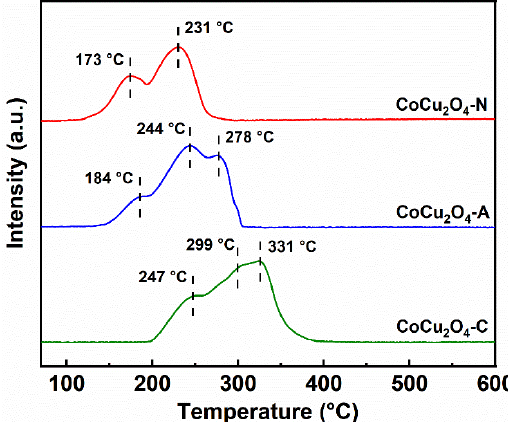
Figure 5. H 2 -TPR profiles of the CuCo 2 O 4 - x ( x = N, A and C) catalysts. Figure 6a shows the O 2 -TPD profiles of the CuCo 2 O 4 - x ( x = N, A and C) catalysts. The oxygen desorption peaks below 500 °C belong to adsorbed oxygen species (e.g., O 2 , O - 2 and O - , labeled as α -O 2 ) [32], while the oxygen desorption peaks between 600 °C and 850 °C belong to the lattice oxygen species (O 2− , labeled as β -O 2 ) [33]. Figure 6b shows the enlarged O 2 -TPD profiles in the temperature range of 50 °C to 550 °C. The oxygen desorp- tion peaks within 50 – 300 °C and 300 – 500 °C correspond to the physically adsorbed oxygen (α 1 -O 2 ) and chemically adsorbed oxygen (α 2 -O 2 ) species, respectively [34,35]. Generally, the adsorption of oxygen followed the procedure of O 2 → O − 2 → O - → O 2− [27]. The CuCo 2 O 4 -N catalyst shows an extra oxygen desorption peak in the temperature range of 200 °C to 250 °C compared to the CuCo 2 O 4 -A and CuCo 2 O 4 -C. The extra oxygen desorption peak could be attributed to physically adsorbed oxygen (α 1 -O 2 ), indicating that the catalysts had better oxygen mobility [36]. Similarly, Li et al. also reported that the CuCo 2 O 4 and NiCo 2 O 4 catalysts showed an extra oxygen desorption peak in the temperature range of 200 °C to 250 °C compared to the ZnCo 2 O 4 . The catalytic performance of CuCo 2 O 4 and NiCo 2 O 4 catalysts were found to be far superior to that of ZnCo 2 O 4 in toluene combustion [7]. The desorption amount of α 1 -O 2 and α 2 -O 2 species were calculated according to the desorption peaks in the O 2 -TPD profiles. As shown in Table 2, the amount of O 2 desorption was in the order of CuCo 2 O 4 -N (41.2 µ mol · g − 1 ) > CuCo 2 O 4 - A (27.1 μmol ·g −1 ) > CuCo 2 O 4 -C (25.6 µ mol · g − 1 ), which confirms the existence of more adsorbed oxygen species over the CuCo 2 O 4 -N catalyst.